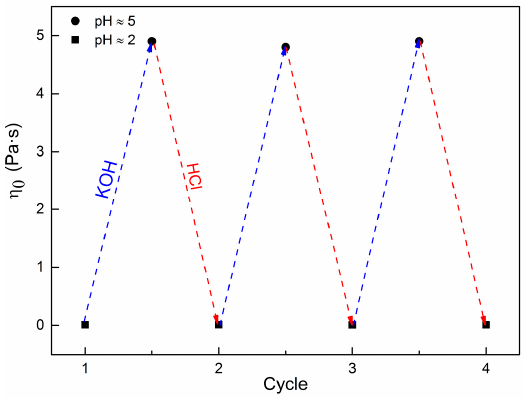
Figure 9. Switchable viscosity of 80 mM C 16 MPBr-AA aqueous solution at different pH values.